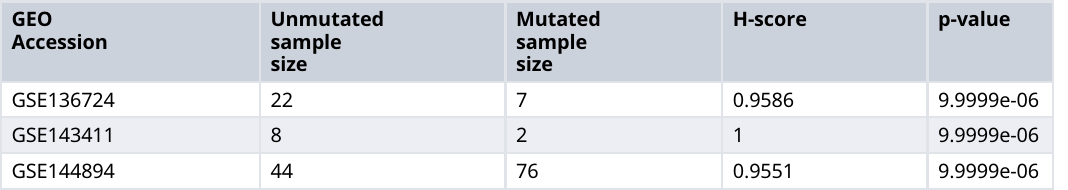
Table 3. H-scores and p-values for the differential methylation signature that differentiate M-CLL and UCLL. GEO